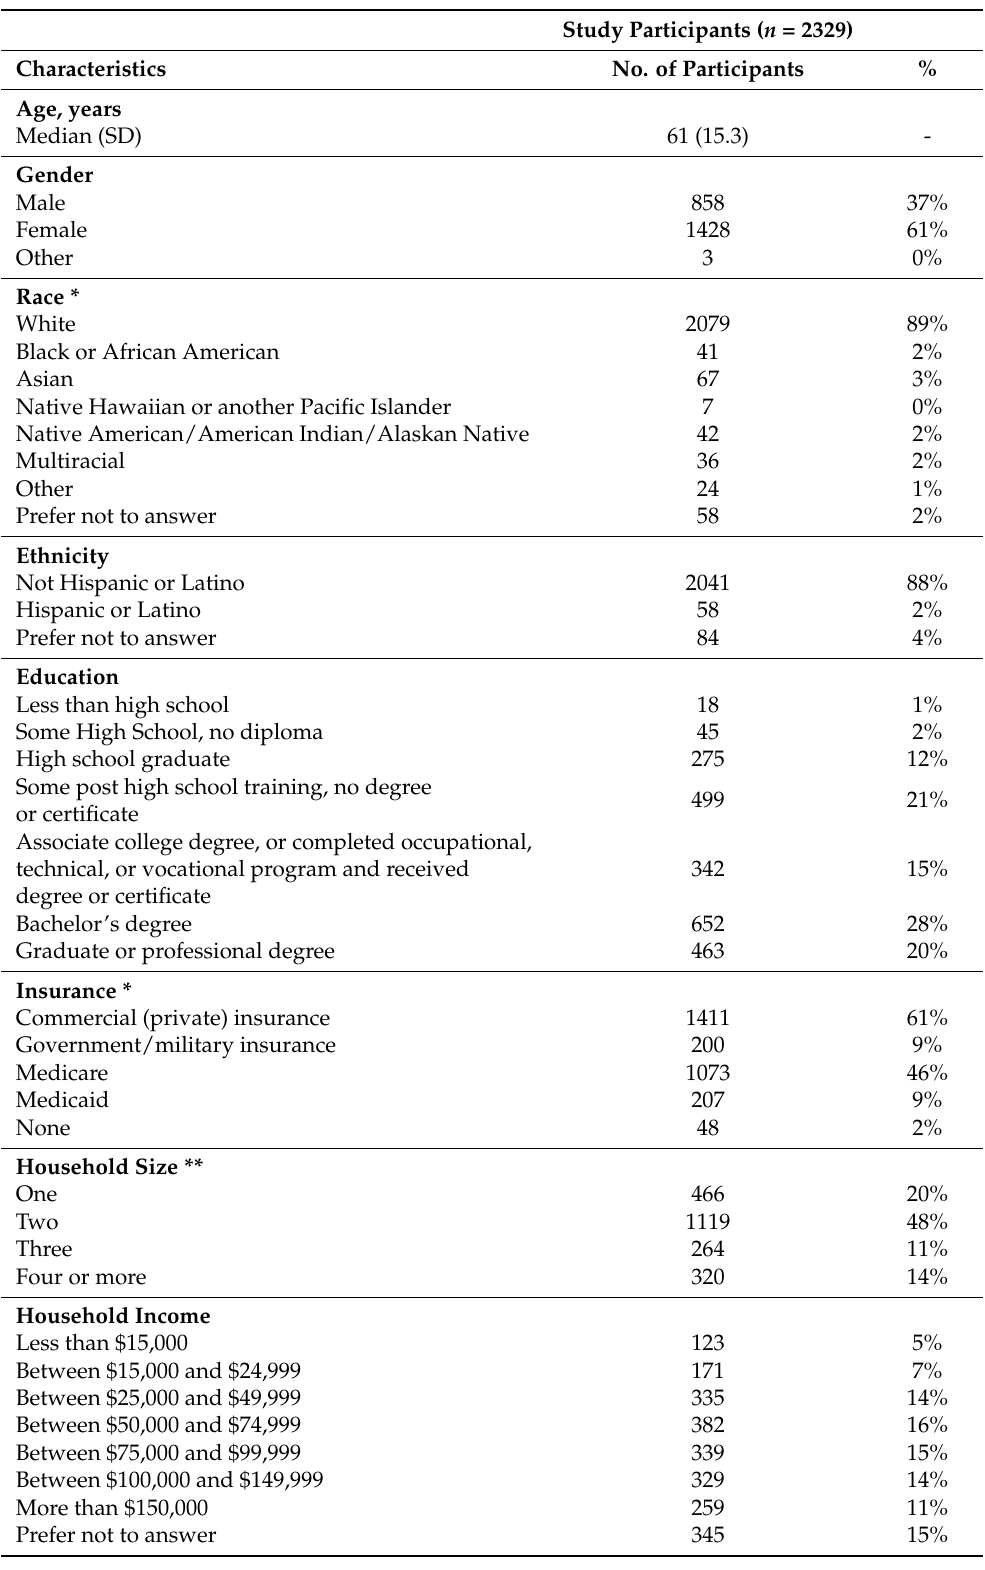
Table 1. Characteristics of the EDGE Patient Baseline Survey